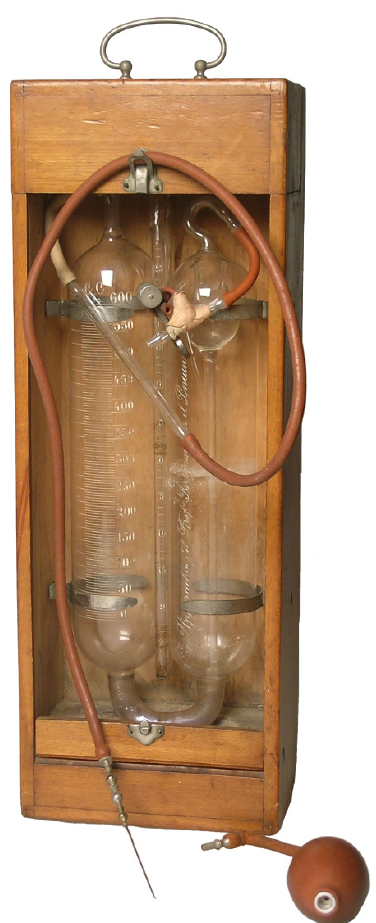
Figure 3. Artificial pneumothorax: Forlanini’s apparatus for the injection of nitrogen into the pleural cavity. Museum for the History of the University of Pavia.